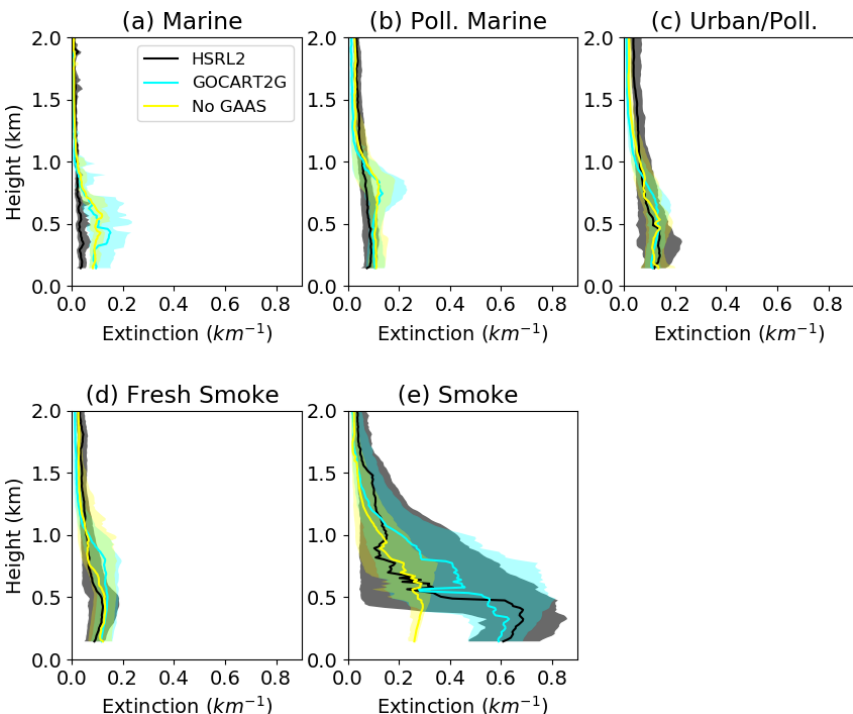
Figure 5. Median extinction at 532nm during all research flights from the HSRL2, GOCART2G, and GOCART2G without aerosol assim- ilation (No GAAS) filtered based on the HSRL2 aerosol ID for (a) marine, (b) polluted marine, (c) urban pollution, (d) fresh smoke, and (e) smoke aerosols. Profiles are shaded between the 25th and 75th percentiles. An analogous figure with all GEOS simulations can be found in the Supplement.